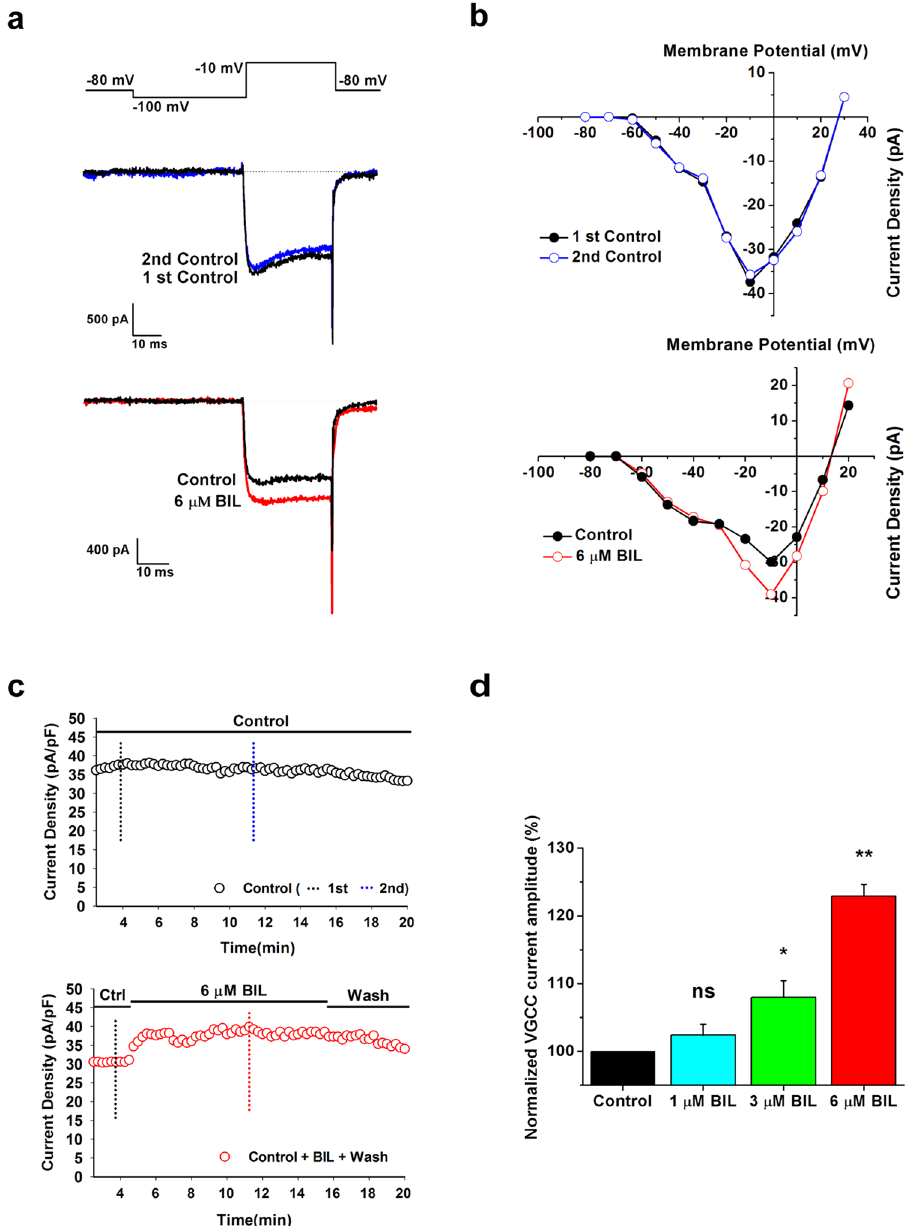
Figure 2. Bilirubin induced increase of VGCC currents. ( a ) Representative traces at − 10 mV for currents obtained in the absence (2nd panel, black trace) or presence of 6 μ M bilirubin (2nd panel, red trace) in the beginning and after about 11 min of the recording. Bilirubin-induced increase was not due to run-up of VGCC currents because responses in the control solution after 11 min (2nd control) of the recording remained stable (1st panel, blue trace) as illustrate by recording from another cell. Each current was elicited by a 40 ms step to − 10 mV. Using Ba 2 + as charge carrier, the peak inward current apparently increased by bilirubin, but showed no significant inactivation. ( b ) Current–voltage relationships from an experiment before and after application of 6 μ M bilirubin. In each case, the holding potential was − 80 mV. Note the increase in maximum amplitude with no shift after application of bilirubin. ( c ) Representative time course of the effect of bilirubin. The control solution was applied for 5 min, followed by the bath application of 6 μ M bilirubin for 10 min and a washout for another 5 min (red circles). By comparison, control currents were measured in standard solution for 20 min (black circles). Currents were evoked by 40 ms step potentials to − 10 mV at 15 s intervals. ( d ) Normalized VGCC current amplitude (%) in the presence of bilirubin at different concentrations: 1 μ M (cyan bar, n = 5), 3 μ M (green bar, n = 22) and 6 μ M (red bar, n = 41). Bilirubin concentrations of 3 μ M and 6 μ M could induce a significant increase in the amplitudes of calcium currents. For the control group, only a standard solution was applied. * P < 0.05, ** P < 0.01, ns, not significant, one-way ANOVA with Bonferroni post hoc